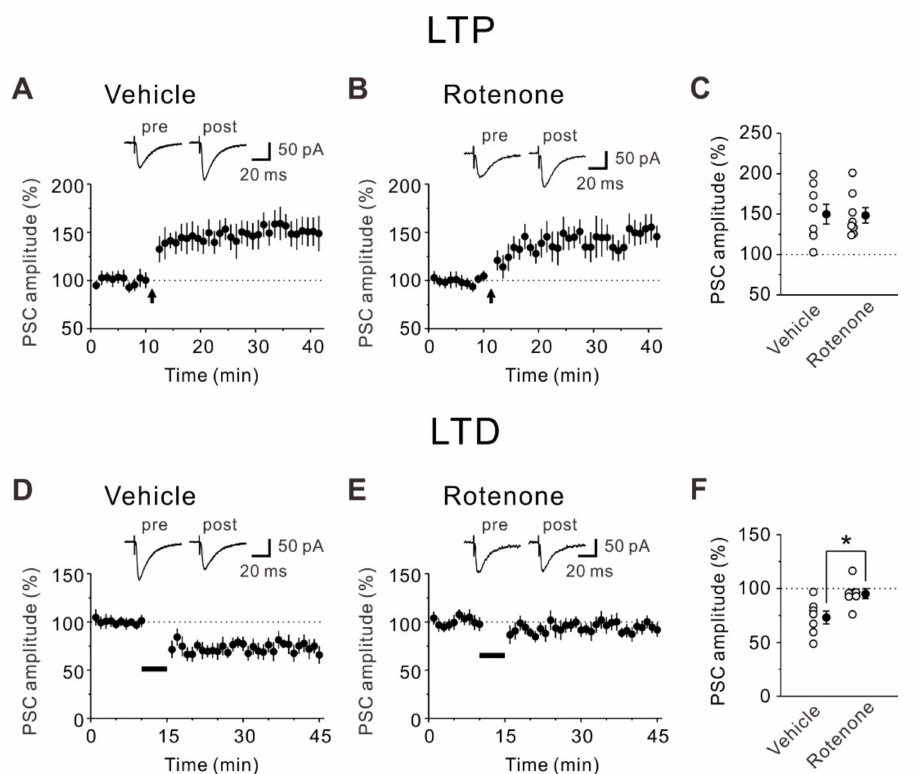
Figure 2. Impairment of LTD caused by intranasal administration of rotenone in layer V pyramidal neurons of the mouse insular cortex. ( A ) Synaptic potentiation was induced by LTP-inducing stimuli (presynaptic 80 pulses at 2 Hz with postsynaptic depolarization at +30 mV) in insular pyramidal neurons of vehicle-treated mice ( n = 8). ( B ) Synaptic potentiation was induced by LTP-inducing stimuli in insular pyramidal neurons of rotenone-treated mice ( n = 8). ( A , B ) The insets show averages of ten consecutive current traces before (pre) and 25–30 min after LTP-inducing stimuli (post). The dashed line indicates the mean basal synaptic responses. LTP-inducing stimuli are indicated by an arrow. ( C ) Summary scatter plots of normalized PSC amplitude obtained in ( A , B ). ( D ) Synaptic depression was induced by LTD-inducing stimuli (presynaptic 300 pulses at 1 Hz with postsynaptic depolarization at − 45 mV) in insular pyramidal neurons of vehicle-treated mice ( n = 7). ( E ) Synaptic depression was not induced by LTD-inducing stimuli in insular pyramidal neurons of rotenone- treated mice ( n = 7). ( D , E ) The insets show averages of ten consecutive current traces before (pre) and 25–30 min after LTD-inducing stimuli (post). The dashed line indicates the mean basal synaptic responses. LTD-inducing stimuli are indicated by a solid bar. ( F ) Summary scatter plots of normalized PSC amplitude obtained in ( D , E ). Unpaired t -test, *: p <